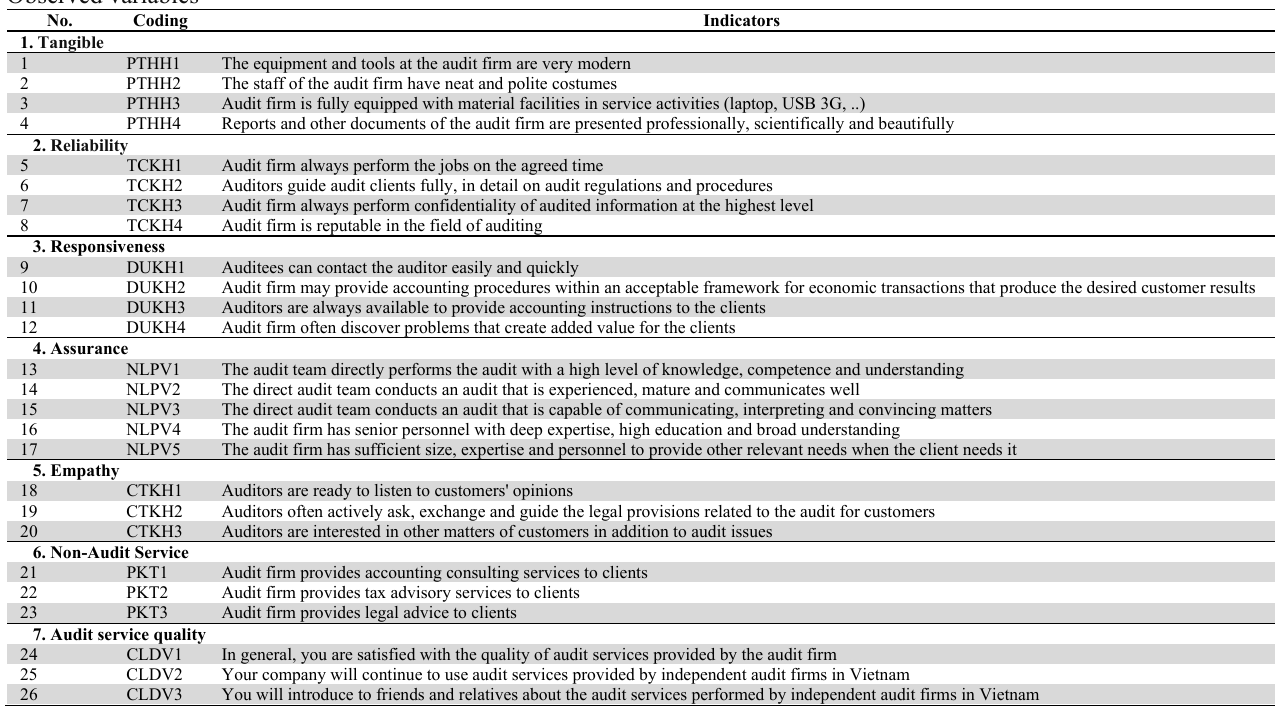
Observed variables No. Coding Indicators 1.